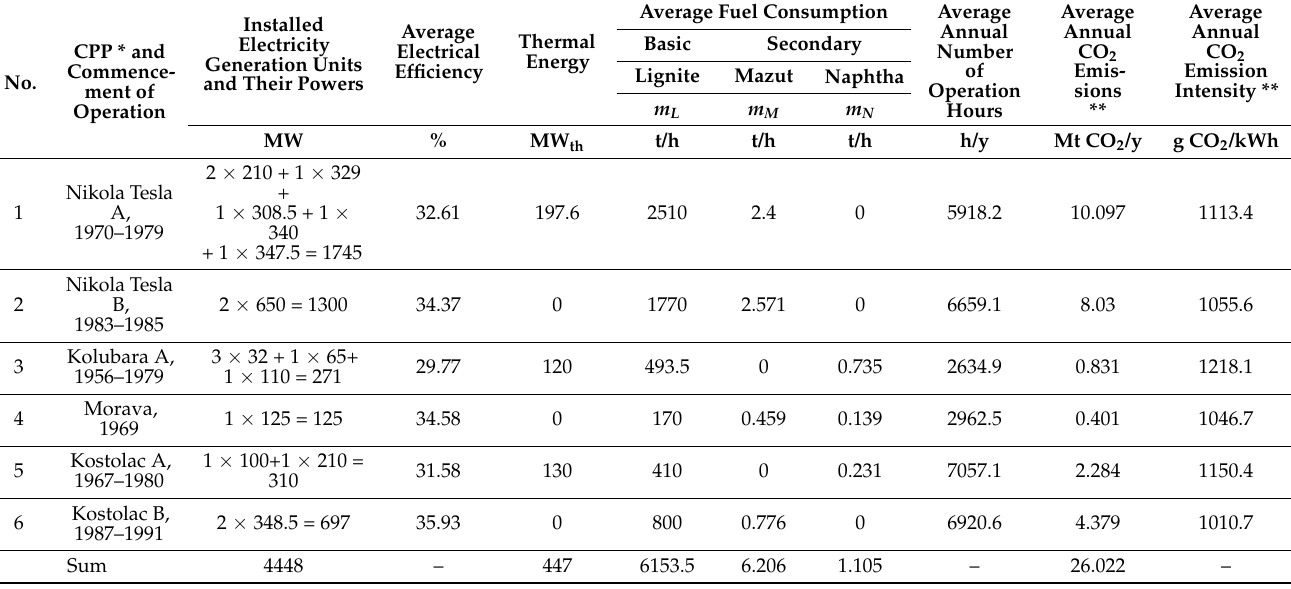
Table A2. An overview of the average performance indicators, average annual CO 2 emissions, average annual CO 2 emission intensities, and some other related information for the existing Serbian CPPs [6].